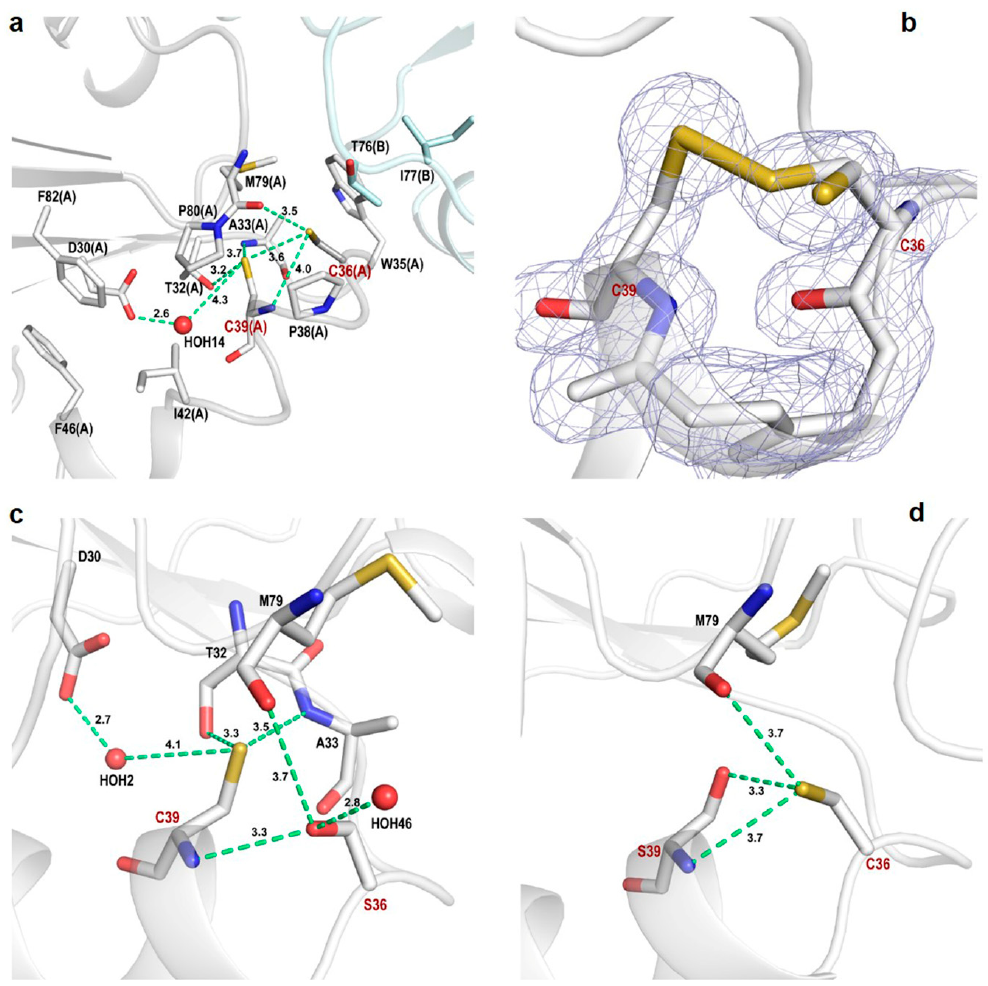
Figure 4. Active site of CrTRXh1. (a) Representation of red-CrTRXh1 active site. Residues are shown as sticks. The interactions of Cys36 (C36) and Cys39 (C39) are shown and the corresponding distances are indicated. (b) Representation of ox-CrTRXh1 active site and the corresponding 2F o − F c electron density map (contoured at 1.5 σ ). The catalytic cysteines are represented as sticks. (c) Representation of C36S mutant active site. Residues are shown as sticks. The interactions of Ser36 (S36) and Cys39 (C39) are shown and the corresponding distances are indicated. (d) Representation of C39S mutant active site. Residues are shown as sticks. The interactions of Cys36 (C36) are shown and the corresponding distances are indicated.